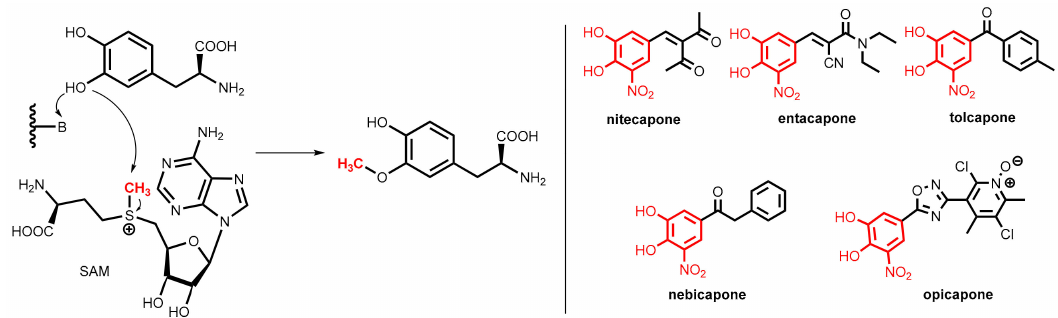
Figure 27. ( Left ): Regioselective O -methylation of levodopa catalyzed by COMT, the methyl group (in red) is provided by S -adenosylmethionine (SAM). ( Right ): Clinically relevant COMT inhibitors: nitecapone, entacapone, tolcapone, nebicapone, and opicapone. All of them share the nitrocatechol pharmacophore (highlighted in